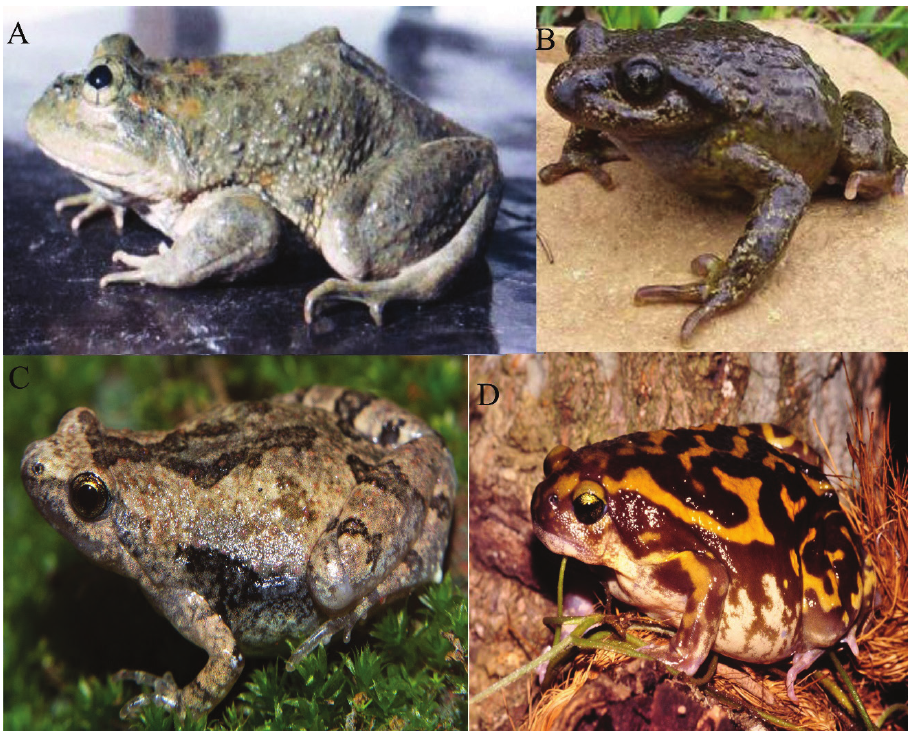
Figure 4. A Karez Frog ( Chrysopaa sternosignata ) B Ladakh Pelobatid Toad ( Scutiger occidentalis ) C Ant Frog ( Microhyla nilphamariensis ) D Marbled Balloon Frog ( Uperodon systoma ). Photographers: Dr Mu- hammad Rais ( A ); Dr Matthias Stöck ( B ); Chaitanya Shukla ( C ); Peter Janzen ( D ).